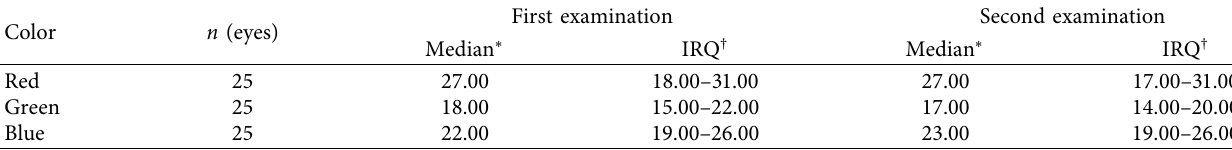
Table 4: Medians and quartiles of the test-retest reliability analysis.